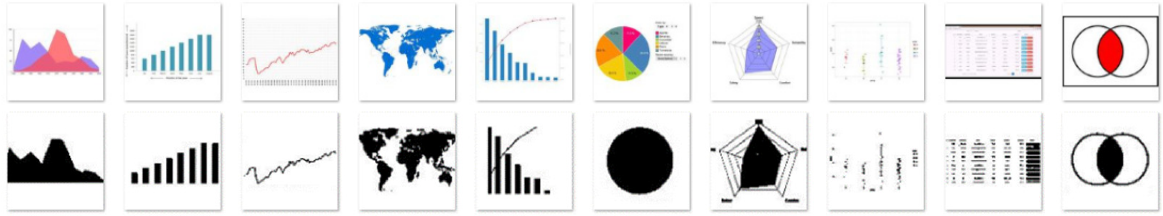
Figure 2. A sample from dataset 1 (3002 images), from left to right: area (308), bar (321), line (287), map (146), Pareto (228), pie (442), radar (401), scatter (288), table (403), and Venn (178). In the top row are original images, and in the bottom, images after pre-processing.